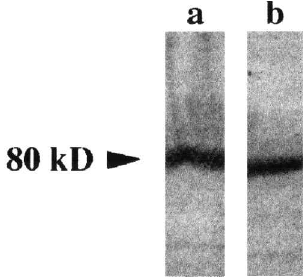
FIG. 1. A representative Western blot (one of three experi- ments) showing the presence of the IL-1 receptor type I (size, 80kD) in the cultured colonic epithelial cells (lane a). Lane b shows the presence of the IL-1 receptor in human monocytes as a positive control.